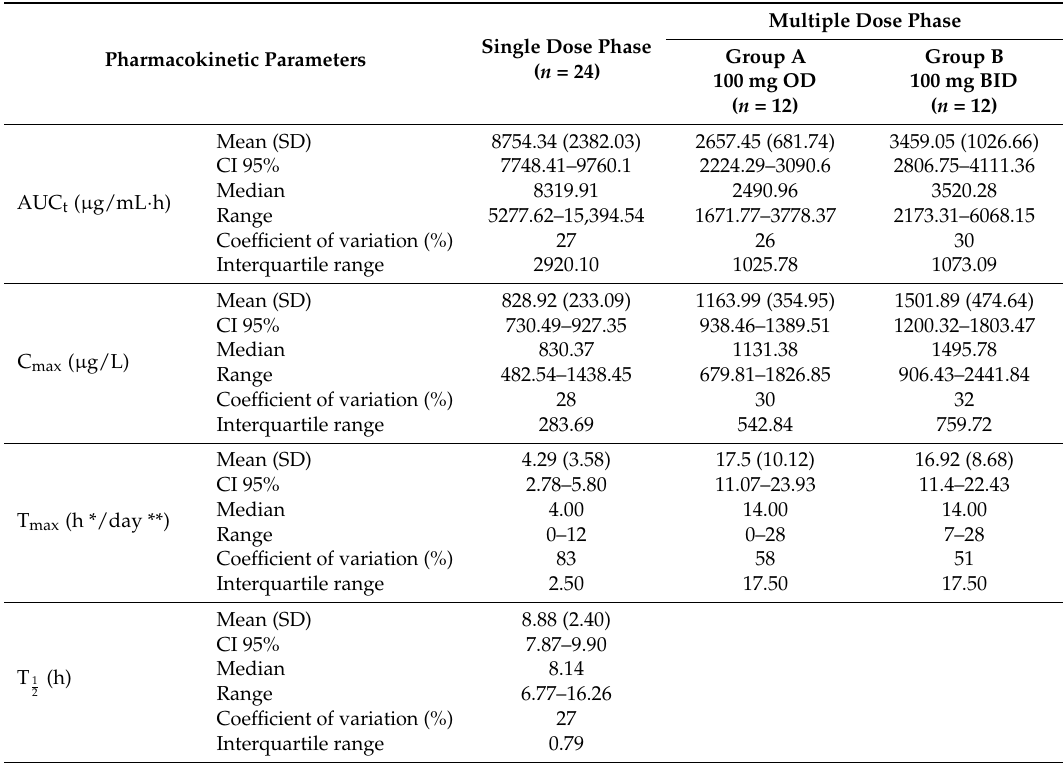
Table 2. Descriptive statistics for pharmacokinetic parameters of CoQ10 in the single and multiple phase—ITT